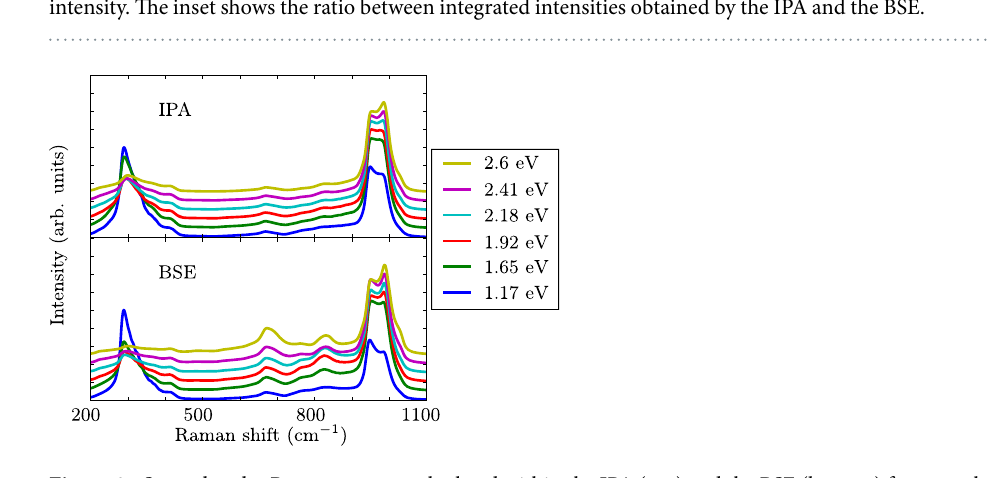
4 prefactor, see Eq. 1 has not been included, and the  . The ω ω − ( ) L L R  L